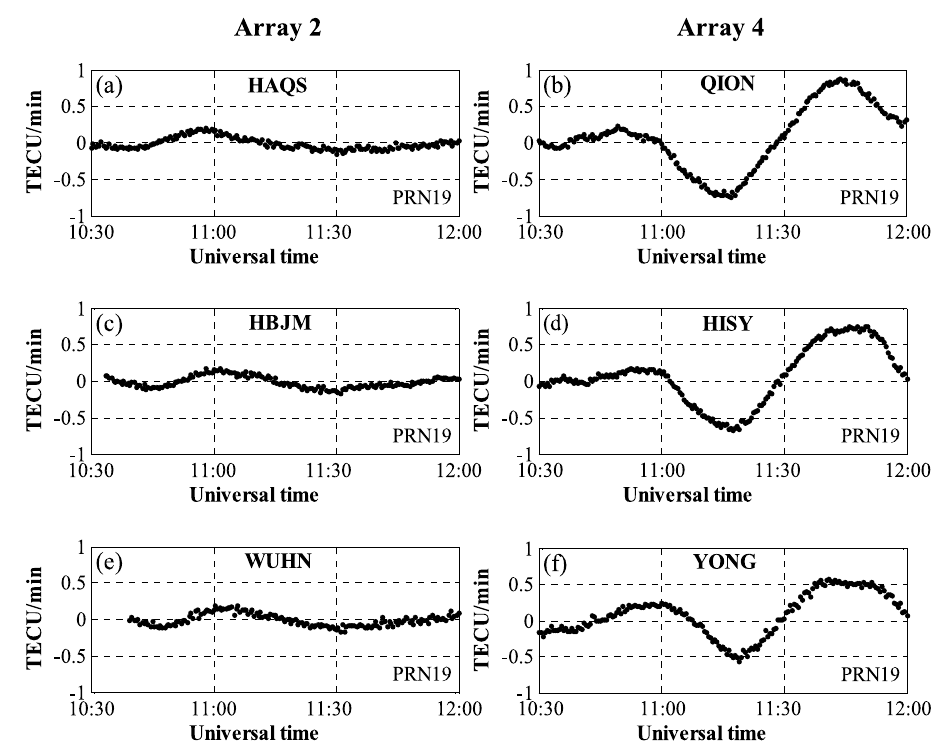
Figure 6. Time series of DROVT from the PRN 19 satellite observed in GPS stations with Array 2 (HAQS-HBJM-WUHN) and Array 4 (HISY-QION-YONG) on 17 March 2015.